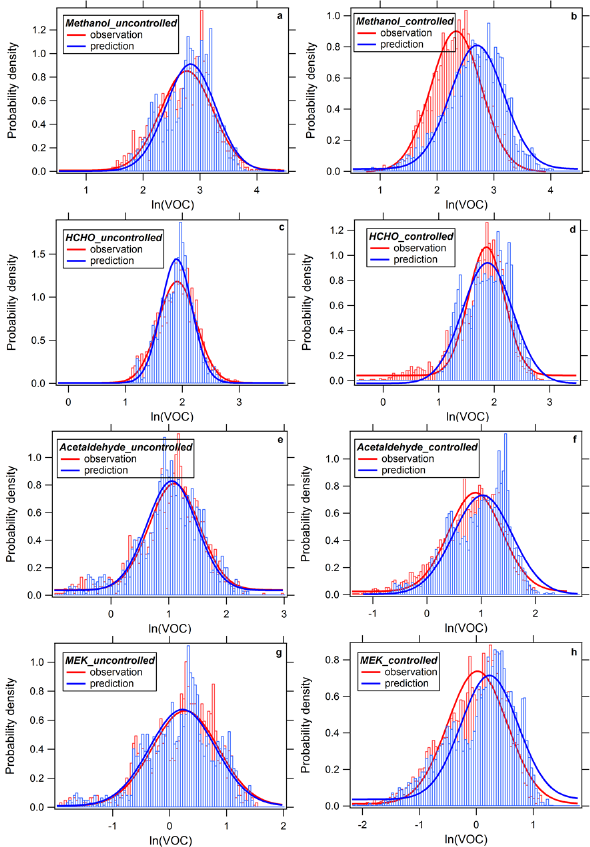
Figure 2. Probability density distribution of the observed ln(VOC) (red) and the predicted values (blue) before the full control (left col- umn) and after the full control (right column) for NMHC species: (a, b) benzene, (c, d) toluene, (e, f) C8 aromatics, and (g, h) ace- tonitrile.